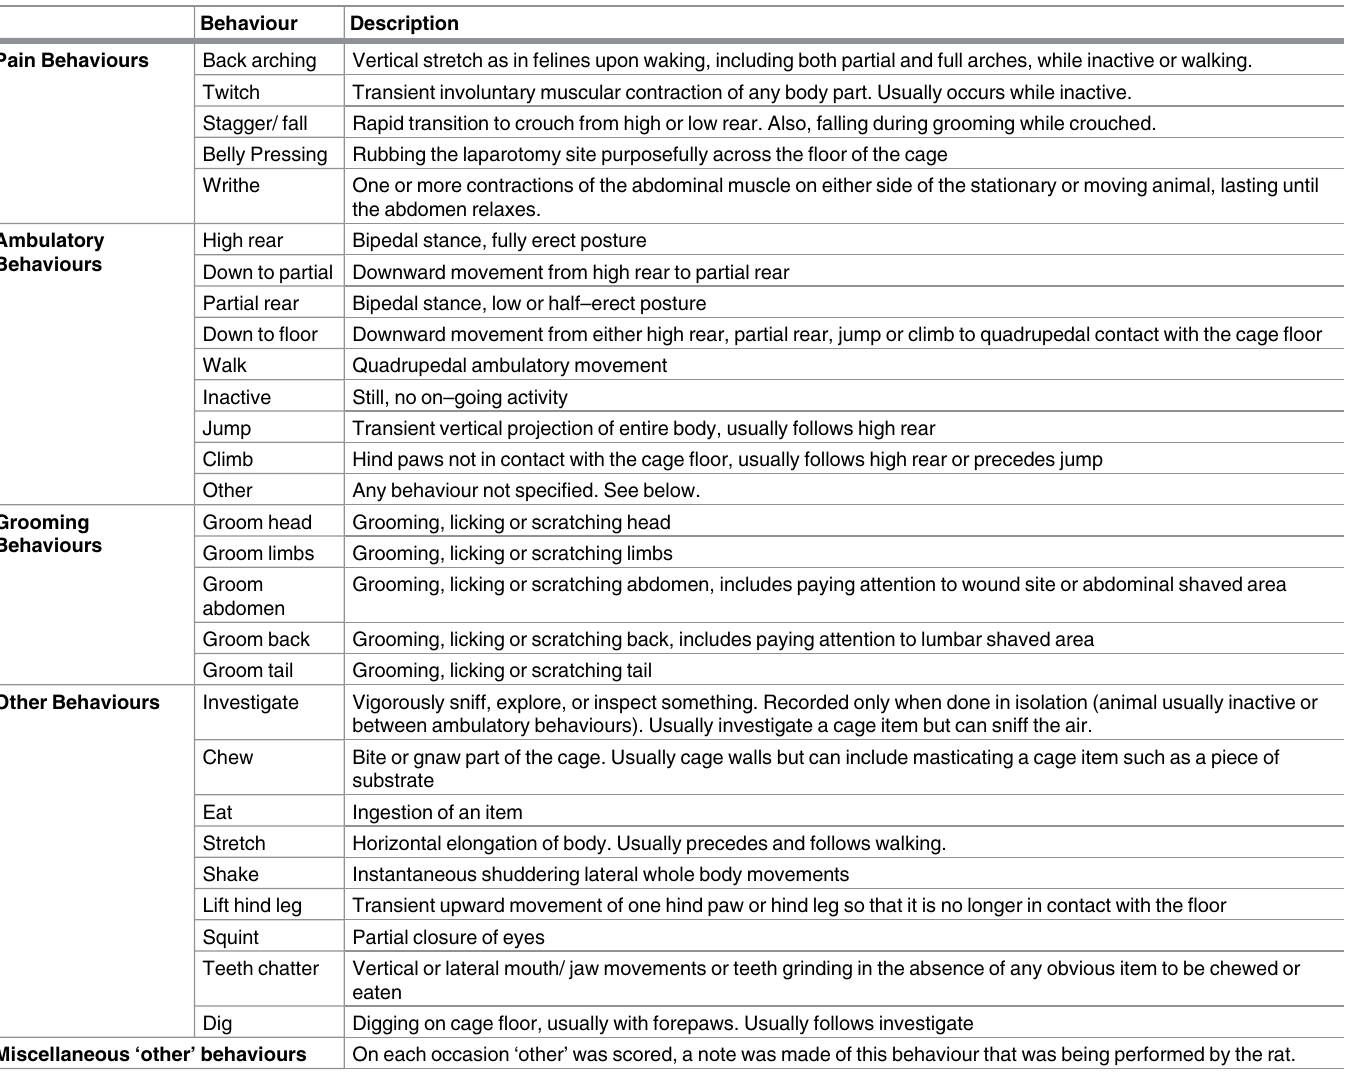
Table 3. Ethogram used for behavioural observations in phase 1. Adapted from references [36,49,51]. Behaviour